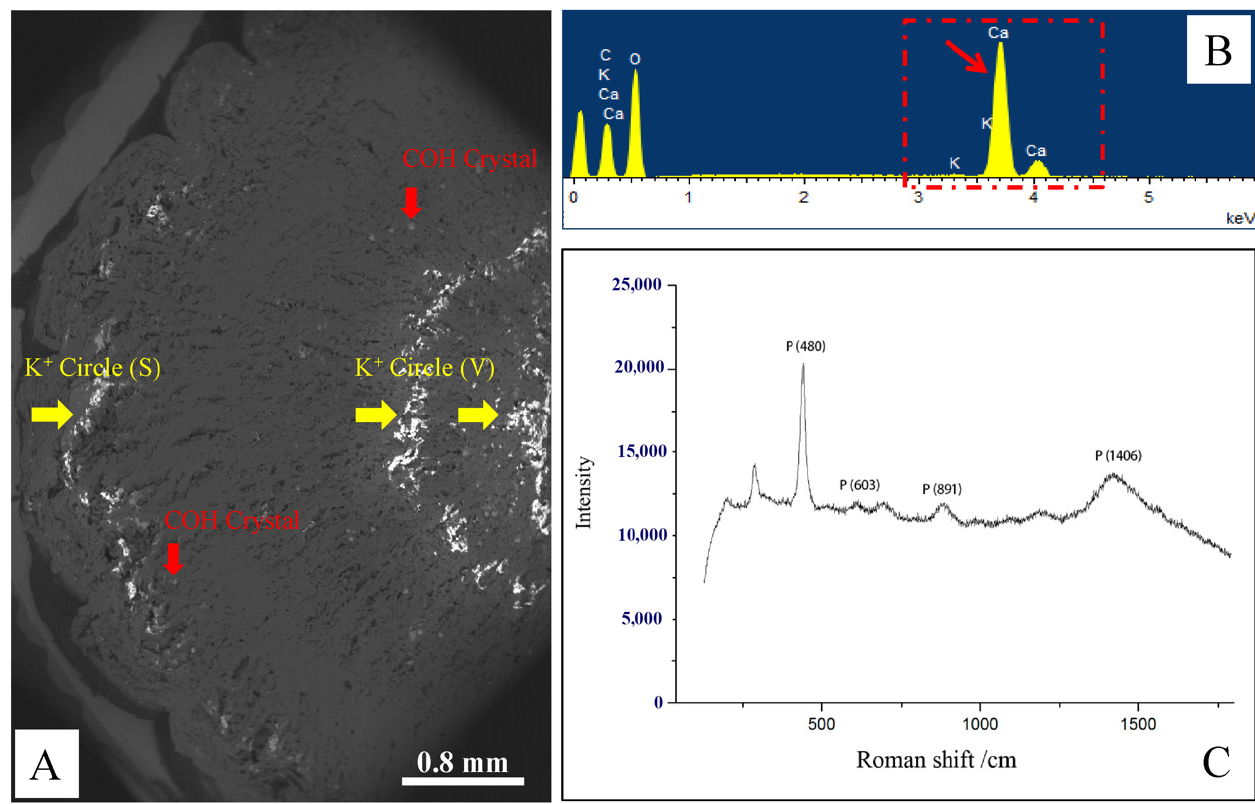
Figure 2. Micro-scale surface analysis for counting of calcium oxalate crystals (COH Crystal) by using the FEG-ESEM system ( A ) and the physical and chemical characterization for COH Crystal through energy spectrum analysis ( B ) and Micro-Raman spectroscopy ( C ).